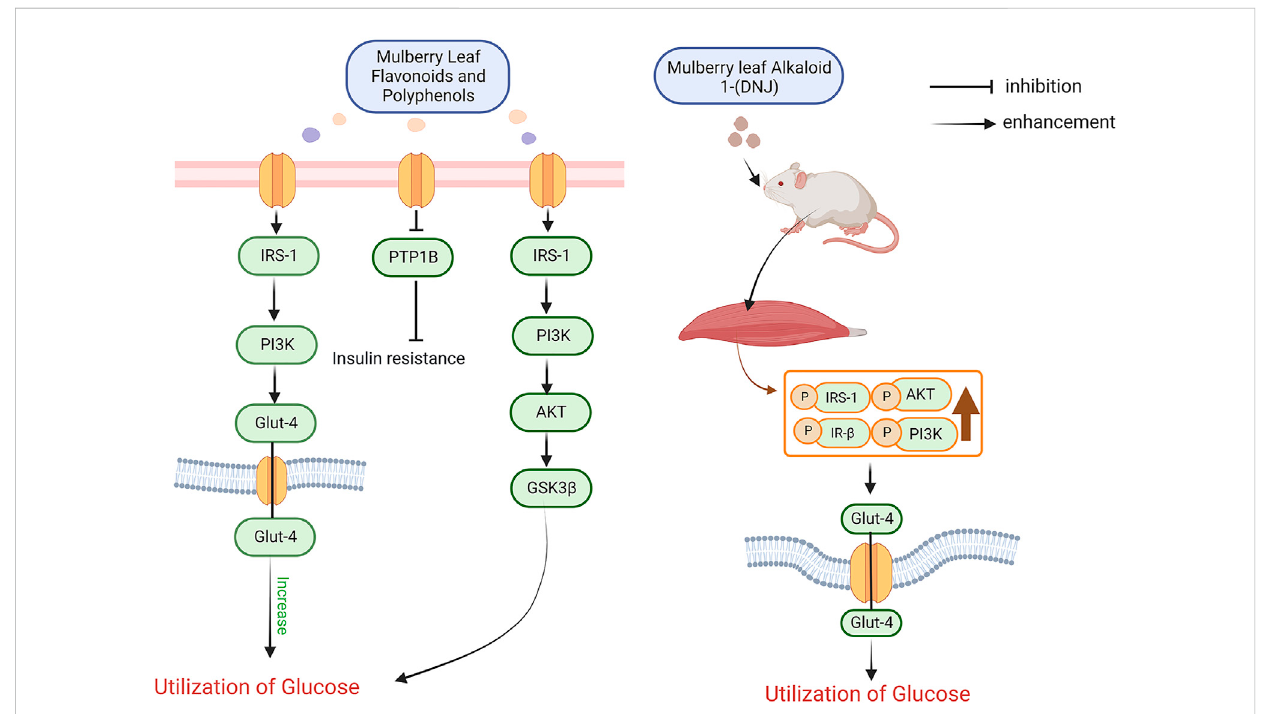
Mechanisms by which mulberry leaves improve insulin resistance to regulate blood